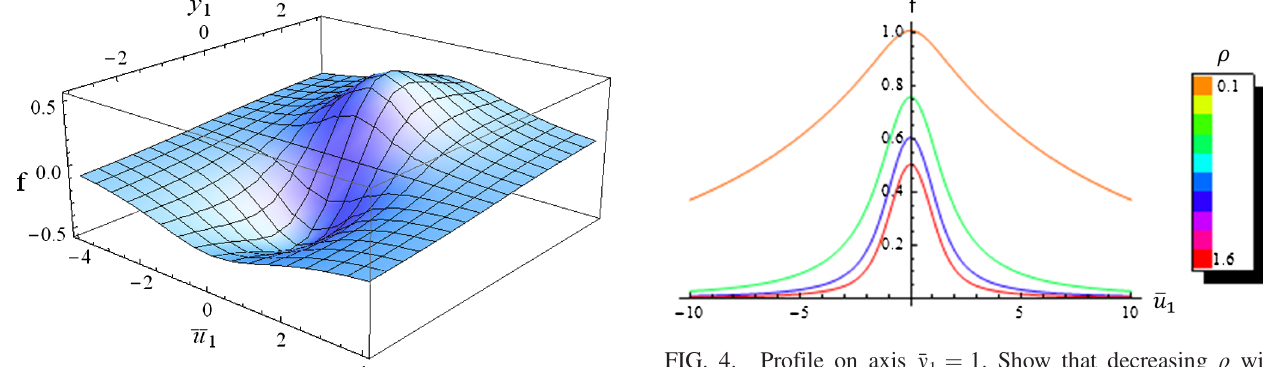
FIG. 4. Profile on axis ¯ y 1 ¼ 1 . Show that decreasing ρ will increase the pulse width. If we need ρ ∼ 1 or ρ > 1 , we need small σ y